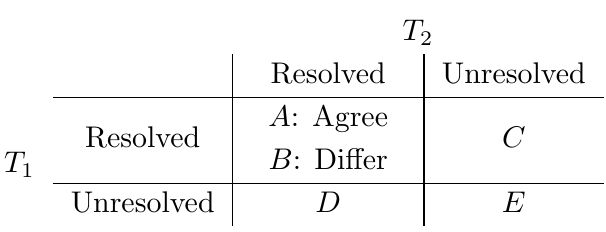
Figure 2. Cases for computing